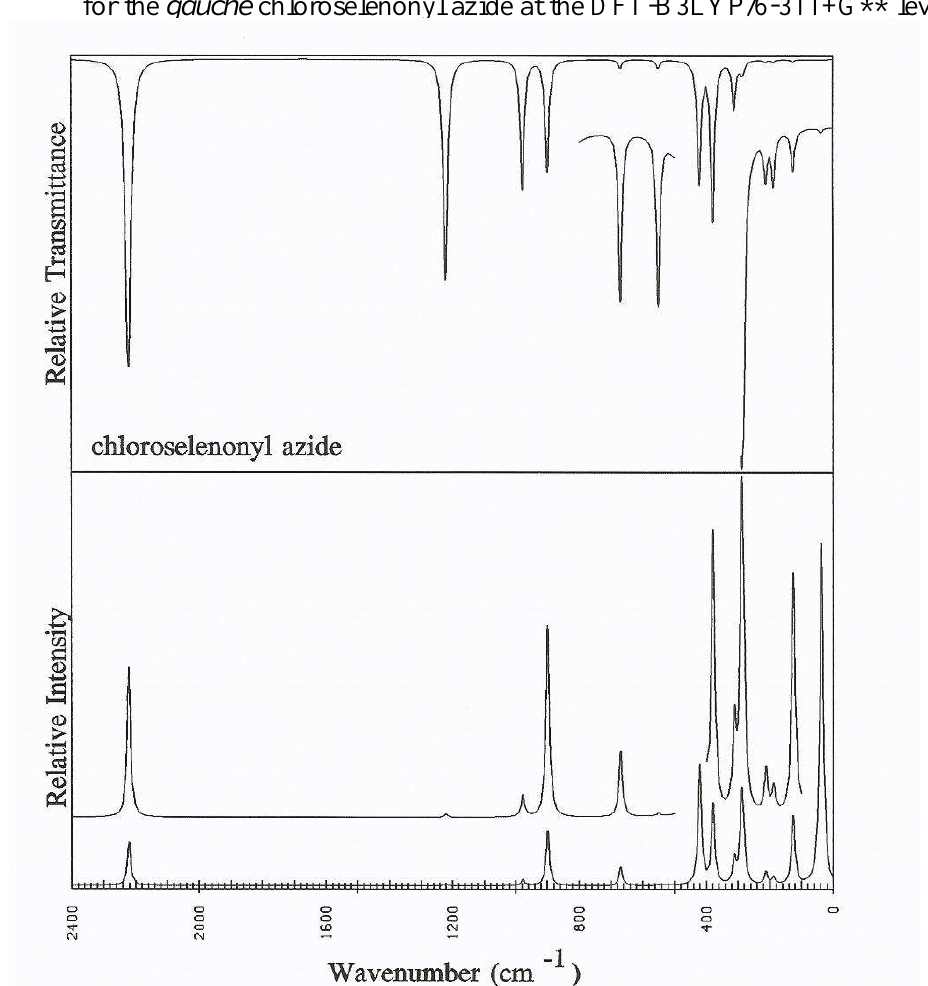
Figure 4 : Calculated vibrational infrared (upper panel) and Raman (lower panel) spectra for the gauche chloroselenonyl azide at the DFT-B3LYP/6-311+G**